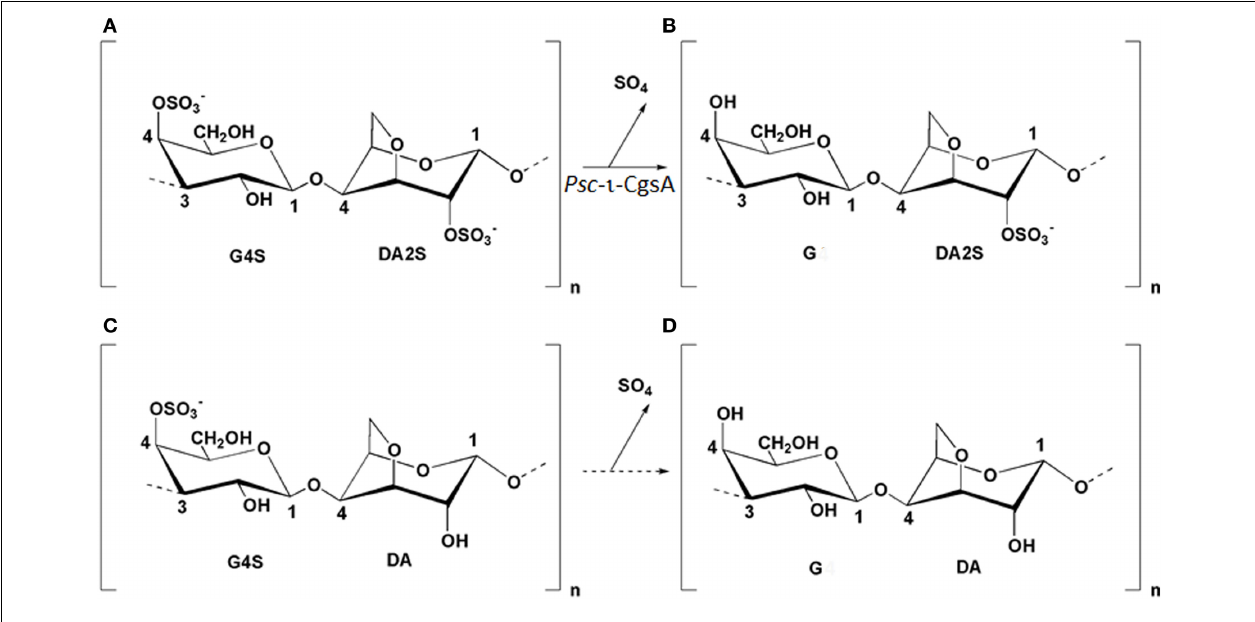
FIGURE 1 | Structure of the idealized repeating units of ι -(G4S-DA2S) (A), α -(G-DA2S) (B), κ -(G4S-DA) (C), and β -(G-DA) (D) carrageenans. The arrow between G4S-DA2S and G-DA2S illustrates the reaction